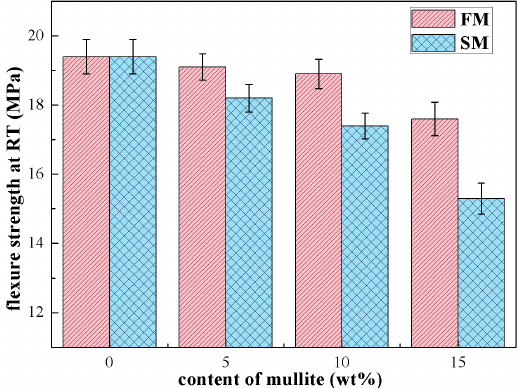
Figure 8. Flexure strength at room temperature of the ceramic cores with different amounts of mullite powders.